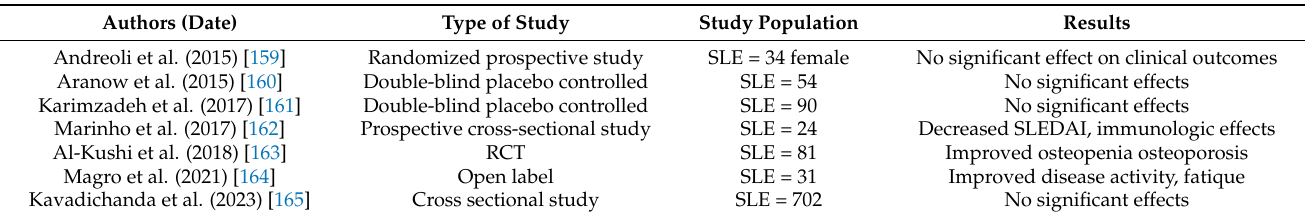
Table 2. Trials in which vitamin D was administered to systemic lupus erythematosus (SLE) patients, RCT = randomized controlled